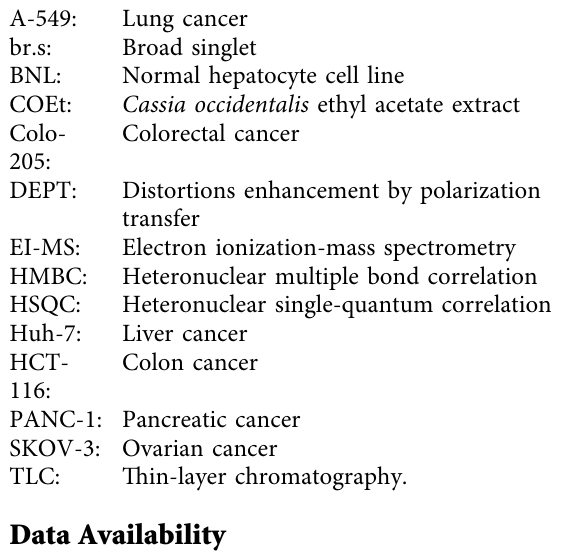
Supplementary Figure (S1): EI-MS spectrum of compound (1). Supplementary Figure (S2): 1H-NMR spectrum of compound (1) (DMSO-d6-400 MHz). Supplementary Figure (S3): 13C-NMR spectrum of compound (1) (DMSO-d6-